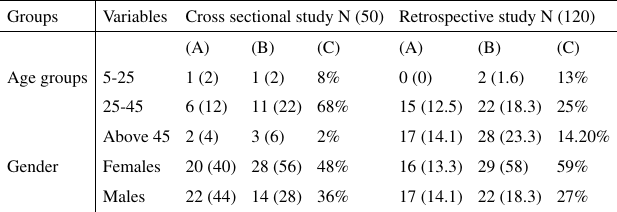
Table 4. Clinical Manifestation and their associated abnormal level of renal test. The frequency (%) of occurrence of symptoms The frequency (% ) of renal dysfunction Clinical manifestation Frequency (%) Abnormal creatinine Abnormal